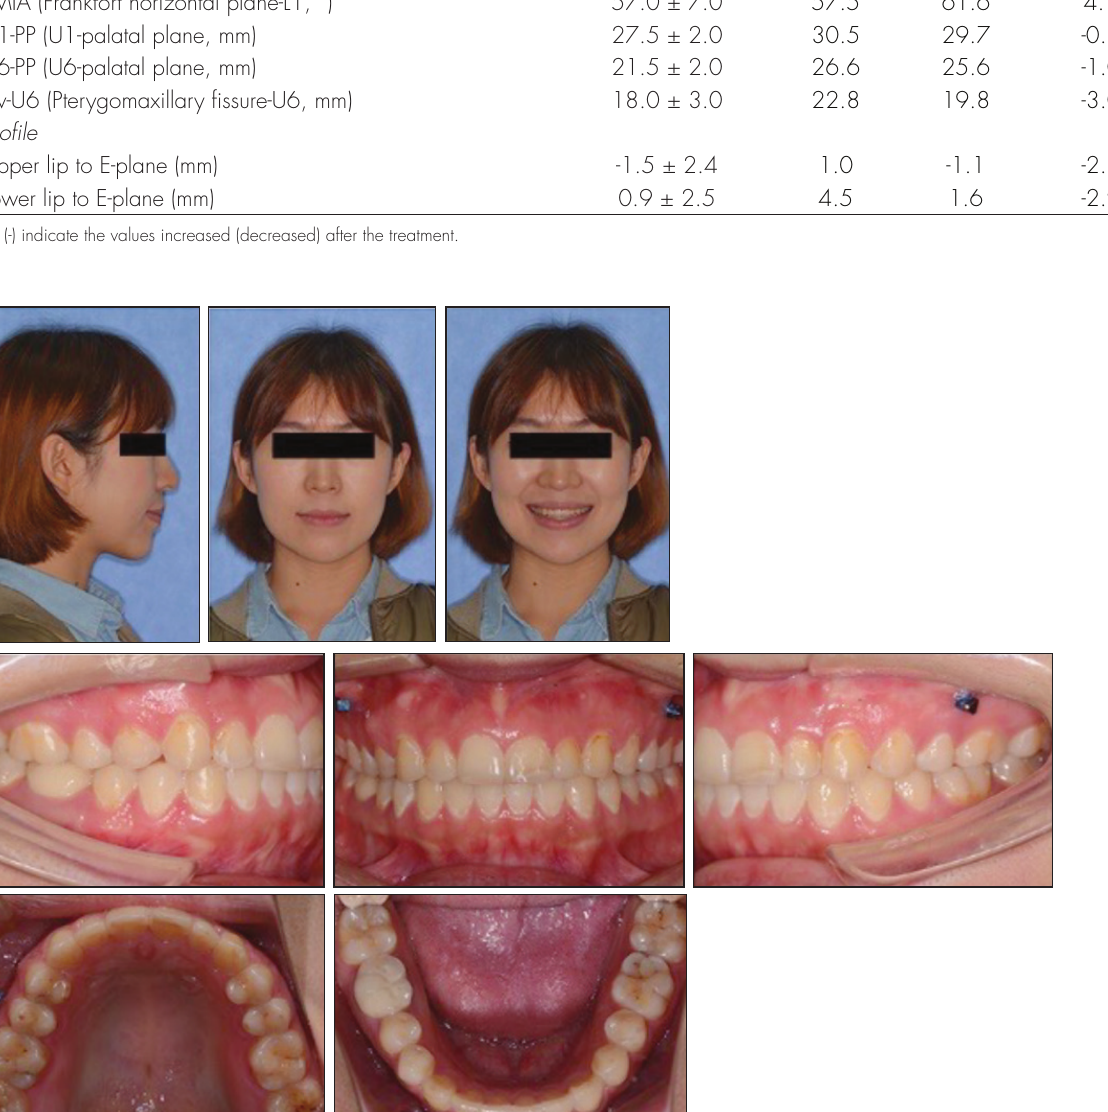
Figure 8. Facial and intraoral photographs after 1.5 years retention. The upper two miniscrews remained in the oral cavity for retention (elastics from the cuts in the retainer to the